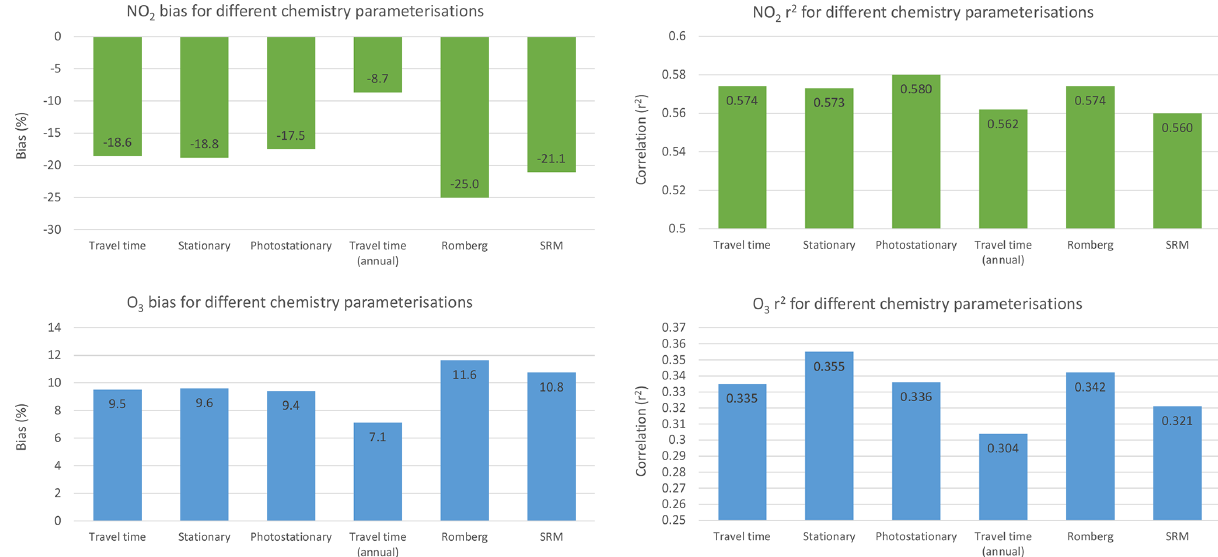
Figure 16. Change in bias and spatial correlation (coefficient of determination r 2 ) for NO 2 and O 3 with implementation of six different versions of the chemistry schemes. See text for